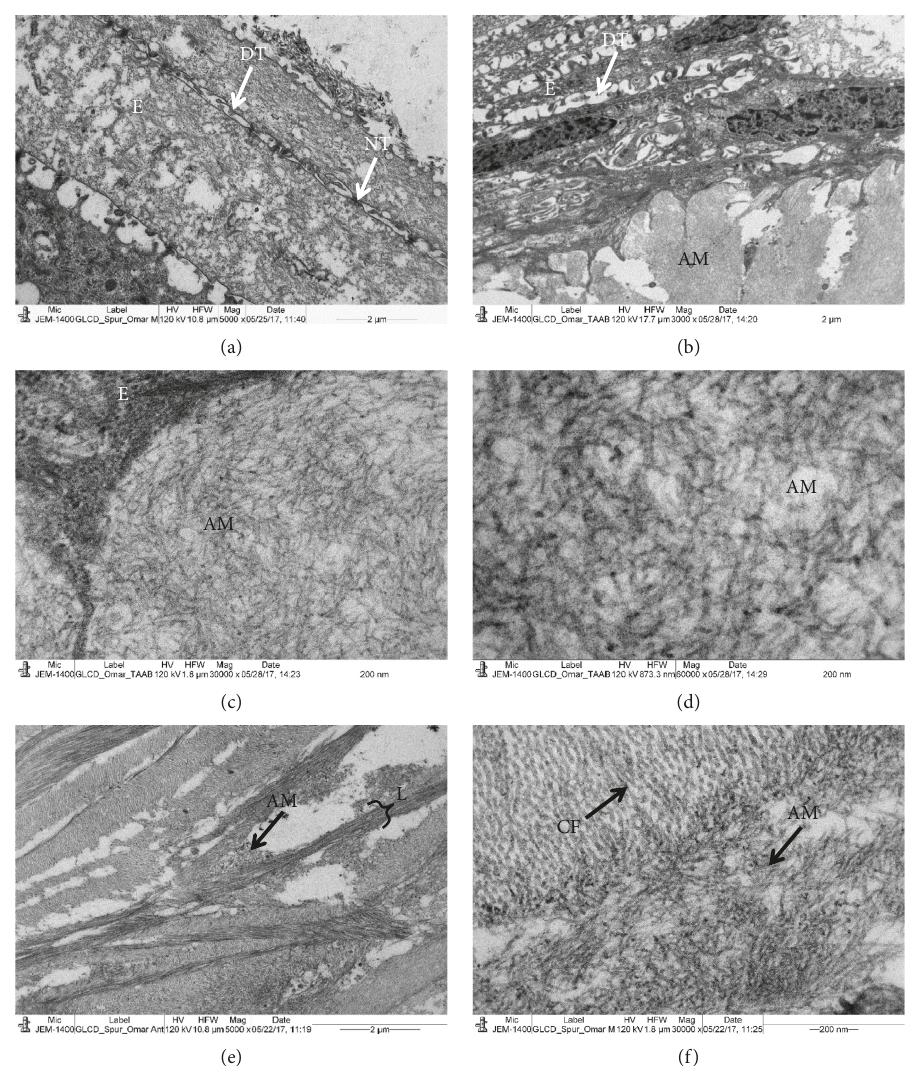
Figure 3: Electron micrograph of GDLD cornea. (a) Part of a degenerated epithelium containing degenerated tight junctions and normal tight junctions. Note that most of the tight junctions are degenerated forming electron-lucent spaces. (b) Numerous running randomly amyloid fibrils deposits at subepithelial region; (c, d) a network of amyloid fibrils at high magnification at subepithelial region; (e) part of the anterior stroma showing a degenerated lamellae and electron-lucent spaces; (f) the stromal amyloid fibrils associated with collagen fibrils. AM: amyloid deposits; CF: collagen fibrils; E: epithelium; L: lamella, TD: degenerated tight junctions; NT: normal tight